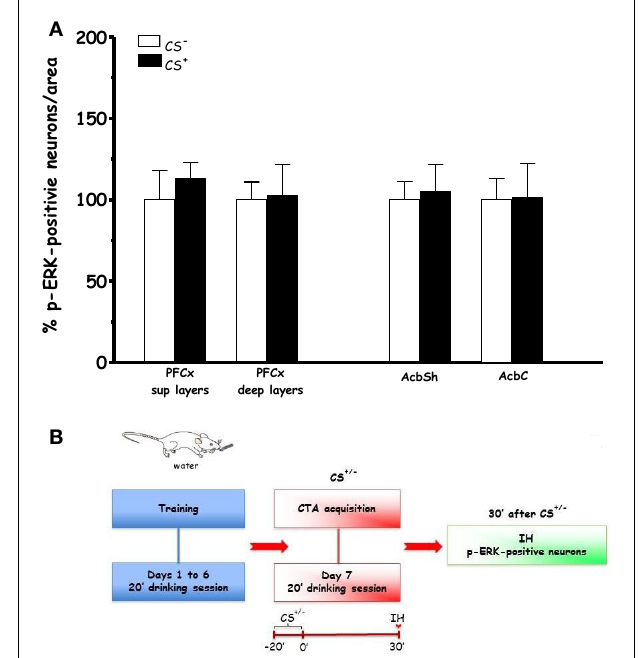
FIGURE 3 | Acquisition (Acq2) (A): Effect of water (CS − ) or sucrose (CS + ) intake on % changes of p-ERK-positive neurons/area in the PFCx (superficial and deep layers) and Acb (shell and core). Data, average + s.e.m., are expressed as % changes with respect to the effect in control group (CS − ) set as 100% ( n = 4 in each group); (B): timeline schedule of Acq2 experiment.